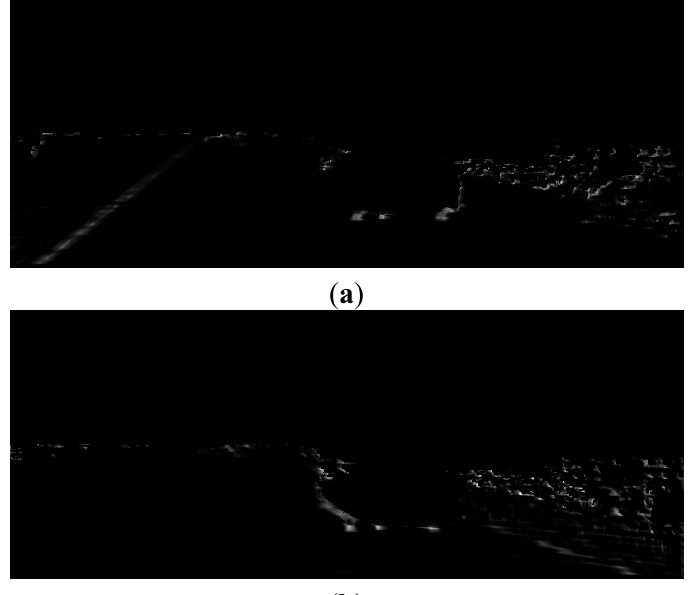
Figure 12. ( a ) Left side curb feature; ( b ) Right side curb